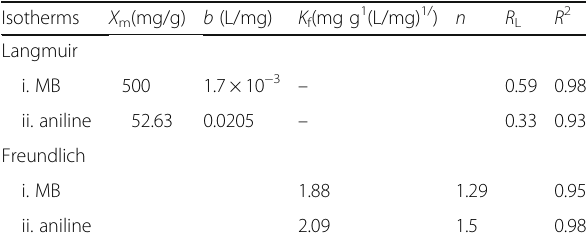
Table 2 Langmuir and Freundlich parameters Isotherms